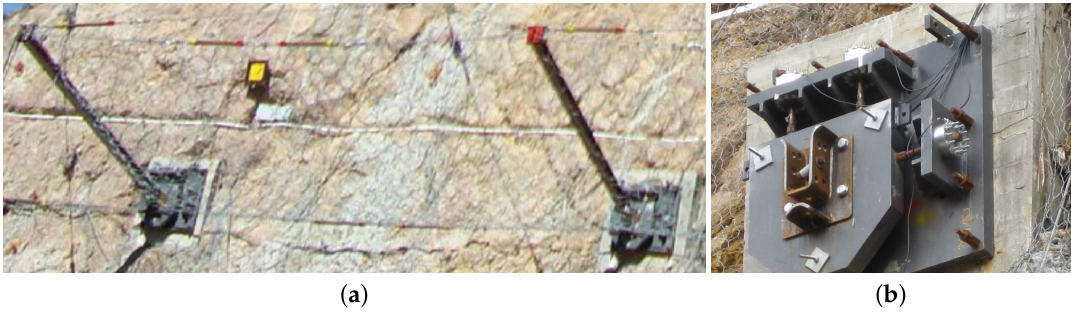
Figure 7. Post base measurement system ( a ) with installed posts at a test site and ( b ) in detail showing three pressure sensors orthogonal to the rock face and three two-way sensor installations parallel to the rock face (source: Igor Paramassi